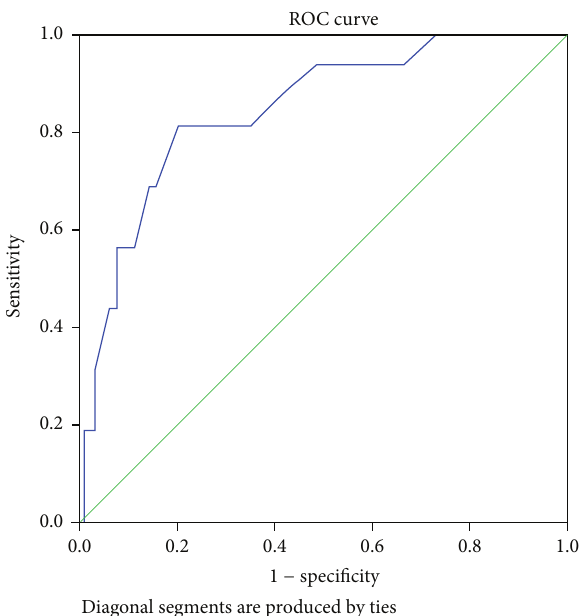
Figure1:ROCcurve:assessmentofexternalvalidityofinstruments. This graph was produced by SPSS 22.0